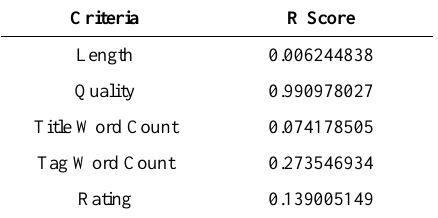
Table 2. Table of R Scores for model with regards to each criterion